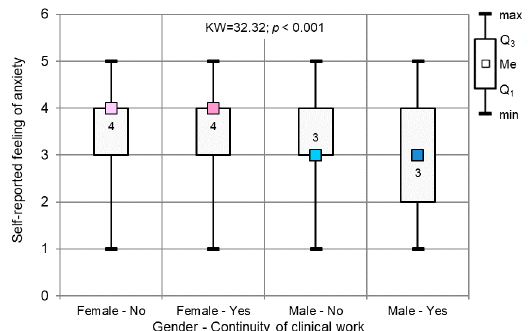
Figure 5. Self-reported anxiety level vs. gender ( p < 0.001, Mann–Whitney test). The Kruskal–Wallis test confirmed (KW = 32.32; p < 0.001) significant differences among four groups of dentists: non-working females, working females, working males and non-working males (Figure 6).